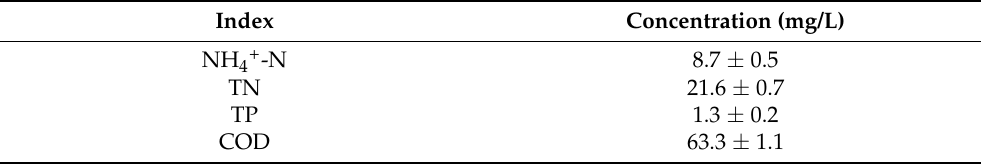
Table 1. Initial concentrations of the lake water.